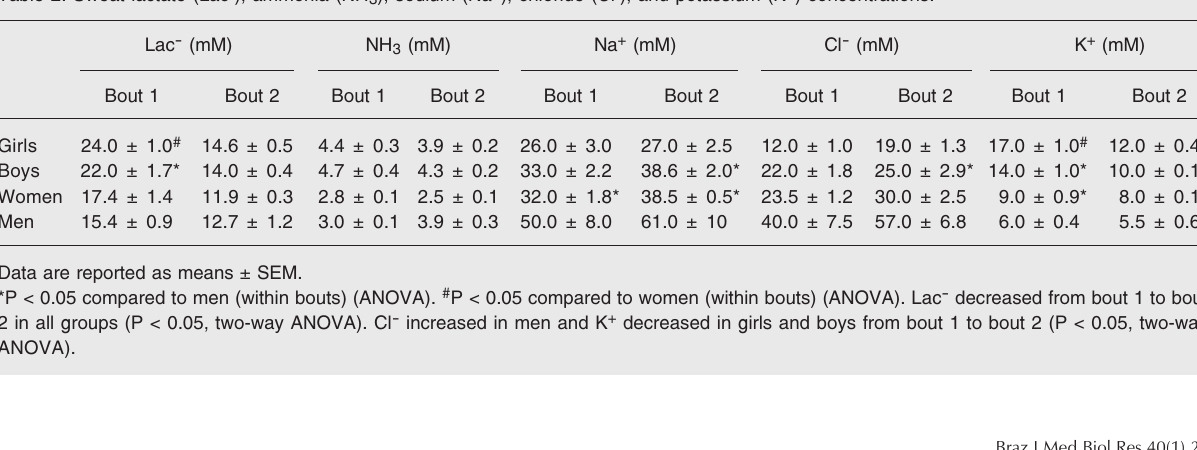
Table 2. Sweat lactate (Lac - ), ammonia (NH 3 ), sodium (Na + ), chloride (Cl - ), and potassium (K + )